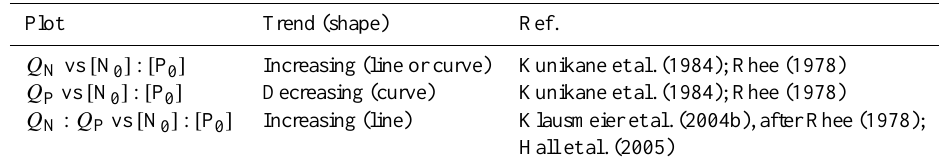
Table 1. Trend (increasing, ↑ , or decreasing, ↓ , function) and shape reported in the literature for the cell content (quota, Q ) of nitrogen and phosphorus when the growth rate, µ , or the dilution rate, w , are varied in laboratory experiments. Plot Trend when N lim. Trend when P lim. Reference (shape) (shape) µ vs Q X ↑ with Q N ↑ with Q P Rhee (1973); Gotham and Rhee (1981a,b); (sat. curve) (sat. curve) Elrifi and Turpin (1985) Q N vs w ↑ ↑ Healey and Hendzel (1979); Terry (1982); (line or curve) (curve) Kunikane et al. (1984); Terry et al. (1985); Healey (1985); Elrifi and Turpin (1985) Q P vs w ↓ or no trend ↑ Goldman et al. (1979); Healey and Hendzel (1979); (line or curve) (curve) Terry (1982); Kunikane et al. (1984); Healey (1985); Terry et al. (1985); Elrifi and Turpin (1985) Q N : Q P vs w ↑ or no trend ↓ Goldman et al. (1979); Healey and Hendzel (1979); (curve) (line or curve) Terry (1982); Elrifi and Turpin (1985) Table 2. Trend and shape reported in experiments for Q when the input ratio [ N 0 ] : [ P 0 ] is varied. Plot Trend (shape) Ref. Q N vs [ N 0 ] : [ P 0 ] Increasing (line or curve) Kunikane et al. (1984); Rhee (1978) Q P vs [ N 0 ] : [ P 0 ] Decreasing (curve) Kunikane et al. (1984); Rhee (1978) Q N : Q P vs [ N 0 ] : [ P 0 ] Increasing (line) Klausmeier et al. (2004b), after Rhee (1978); Hall et al.